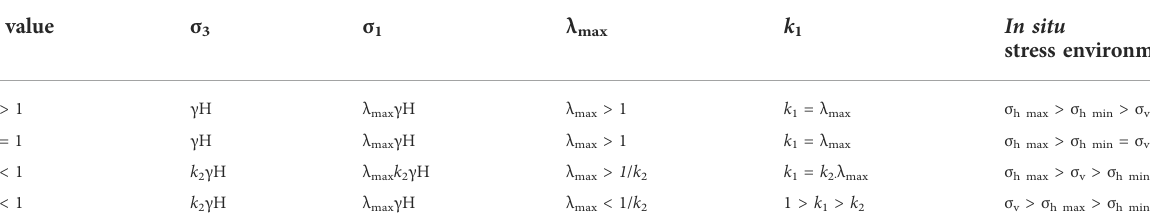
TABLE 2 In situ stress environment analysis.